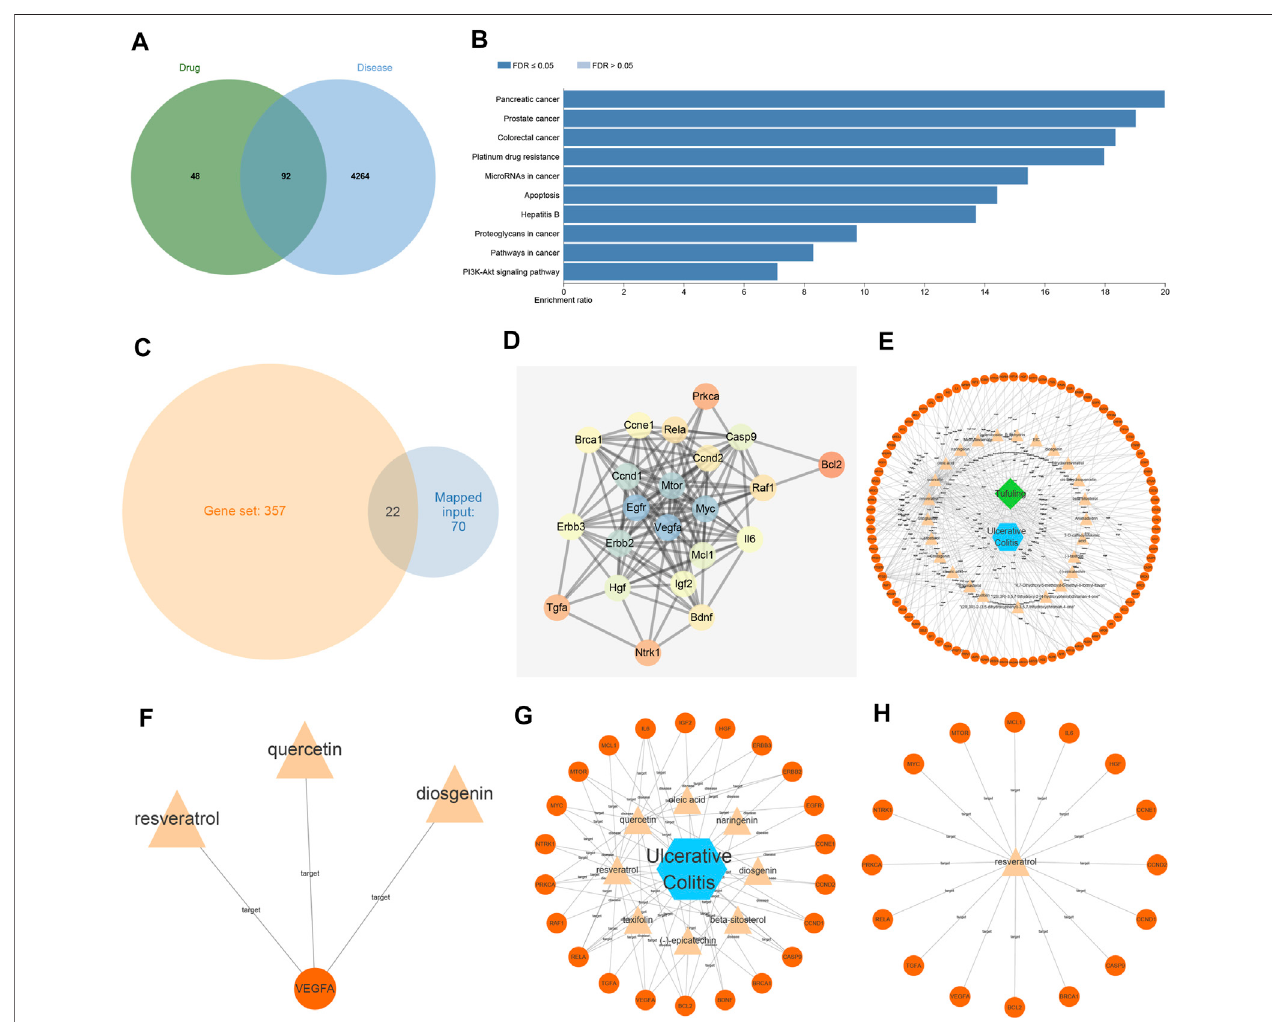
FIGURE1| Resveratrol(RSV)functionsasapotentialtargetforthetherapyofulcerativecolitis(UC). (A) TheoverlappinggenesbetweencompoundtargetsandUC targets in 92 RSG examined by Jvenn. (B) Analysis of KEGG enrichment of overlapping genes between drug targets and disease targets. (C) The overlapping zone betweengenesinvolved inenrichmentanalysisand genes involvedin PI3K/Akt pathway. (D) The correlationand interactionanalysis network between genesinvolved in the PI3K/Akt pathway; the color scale of the circle from orange to blue indicated that the degree value was from small to large. (E) Disease-compound-target relationshipnetworkdiagram; orangerepresentedtargets, yellow compound, bluedisease, and greentraditional Chinesemedicine. (F) Compounds thatregulatedcore targets. (G) Compounds that controlled genes in the PI3K/Akt pathway. (H) Target genes regulated by RSV. VEGFA, vascular endothelial growth factor A.